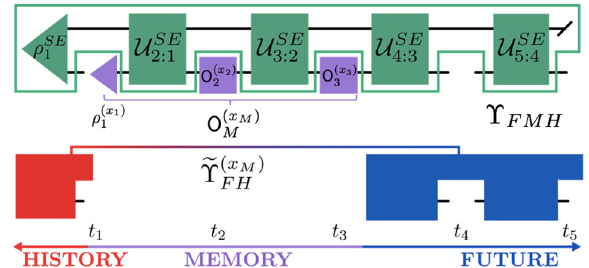
Fig. 2 Quantum stochastic process. An open quantum process with an initial system – environment state and unitary evolutions (green) can be represented as a process tensor ϒ FMH (outline). For each event of a memory instrument sequence, J M ¼ f O ð x M Þ (purple), a conditional future – history process e ϒ ð x M Þ results; future – history correlations evidence memory effects across ℓ ≔ ∣ M ∣ .